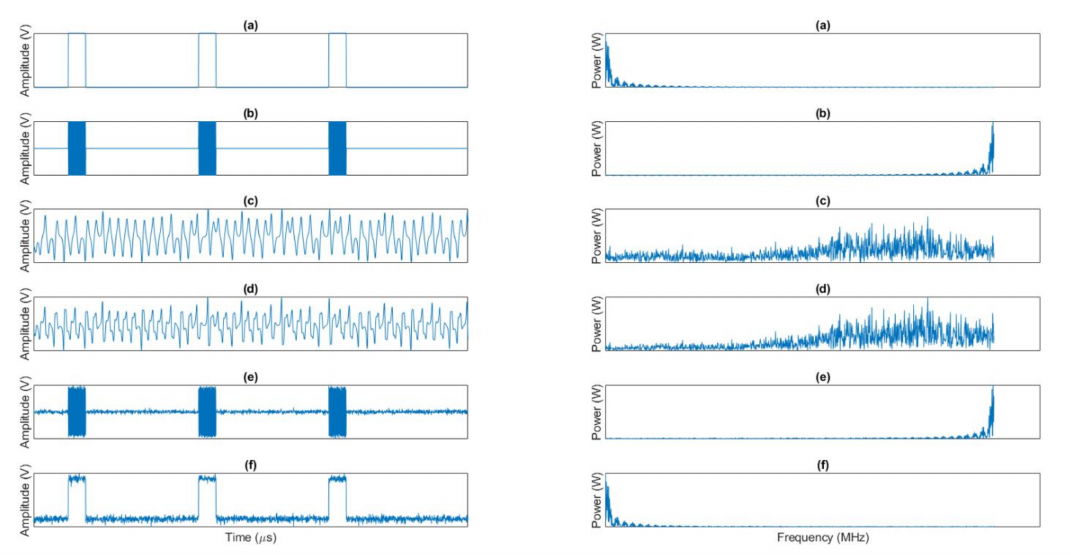
Figure 7. Comparison among the most relevant signals in the time (left) and frequency (right)